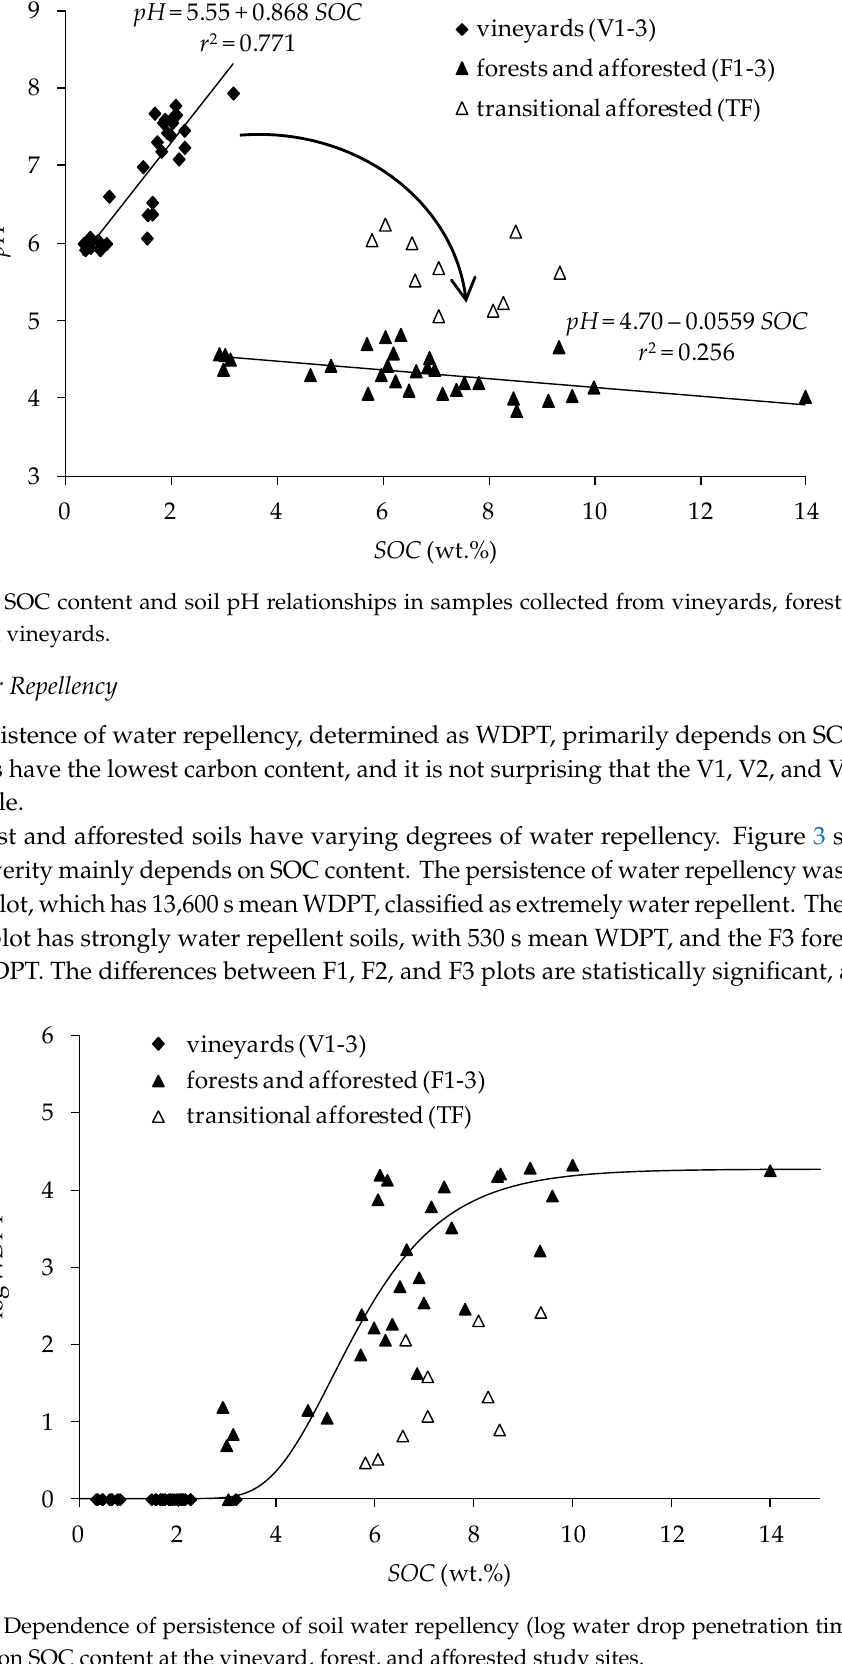
Figure 4. Dependence of infiltration rate ( i ) on the extent of infiltration ( I ). The points show the average values of four independent infiltration measurements in the vineyard and afforested research plots. Equation (1) was fitted to field infiltration data and the regression equations are listed in Figure 6. The C 1 and C 2 constants from these equations reveal that the TF forest-site water repellency decreased both parameters more than an order of magnitude compared to the V1 vineyard site. The lower diagram in Figure 6 shows that the S = C 1 sorptivity had negative values in two instances. Such negative parameter values in Equation (1) are physically impossible and the values suggest that the infiltration course is significantly influenced by changing water repellency, and that infiltration increases when water repellent substances are washed out or removed.